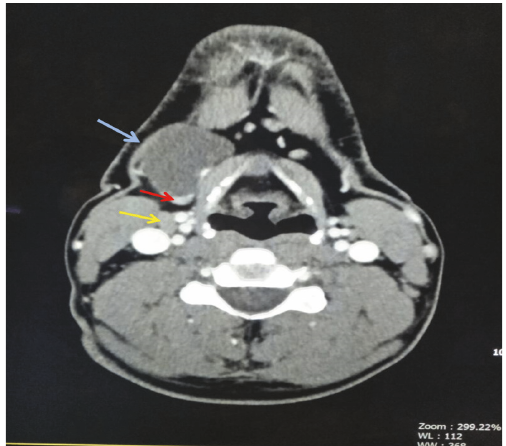
Figure 1: A well-defined cystic lesion (blue arrow) noted at the anteroinferior to the right submandibular gland measuring about 3.0 x 2.0 x 2.2 cm. There is a 0.8 cm enhancing nodule (red arrow) within the lesion. Enlarged submandibular lymph node seen (yellow arrow).